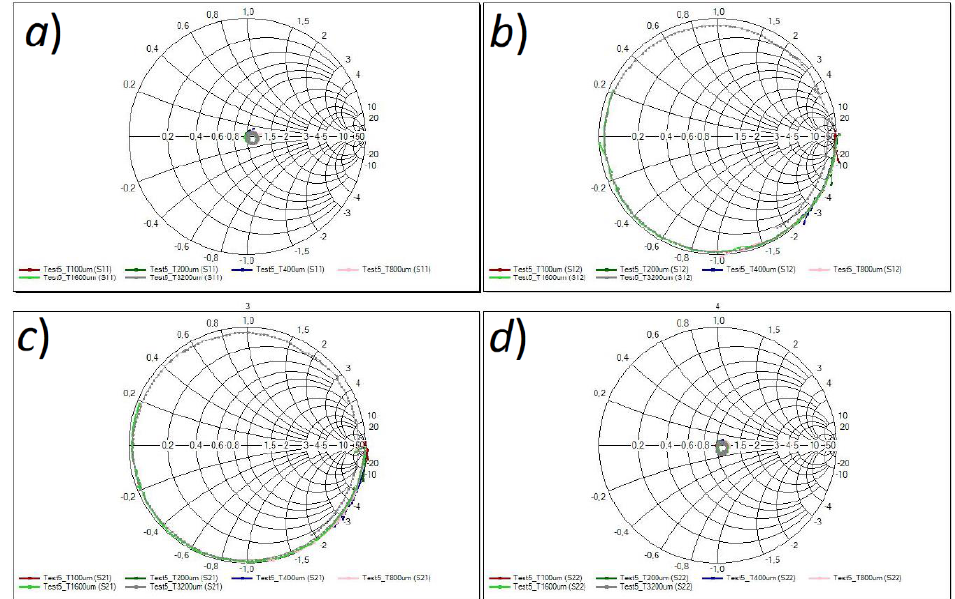
Fig. 3. Small-signal scattering parameters of CMLs with the length l W of 100, 200, 400, 800, 1600, and 3200 um, in the frequency range of 0.1 – 50 GHz: S 11 — a ), S 12 — b ), S 21 — c ), S 22 — d